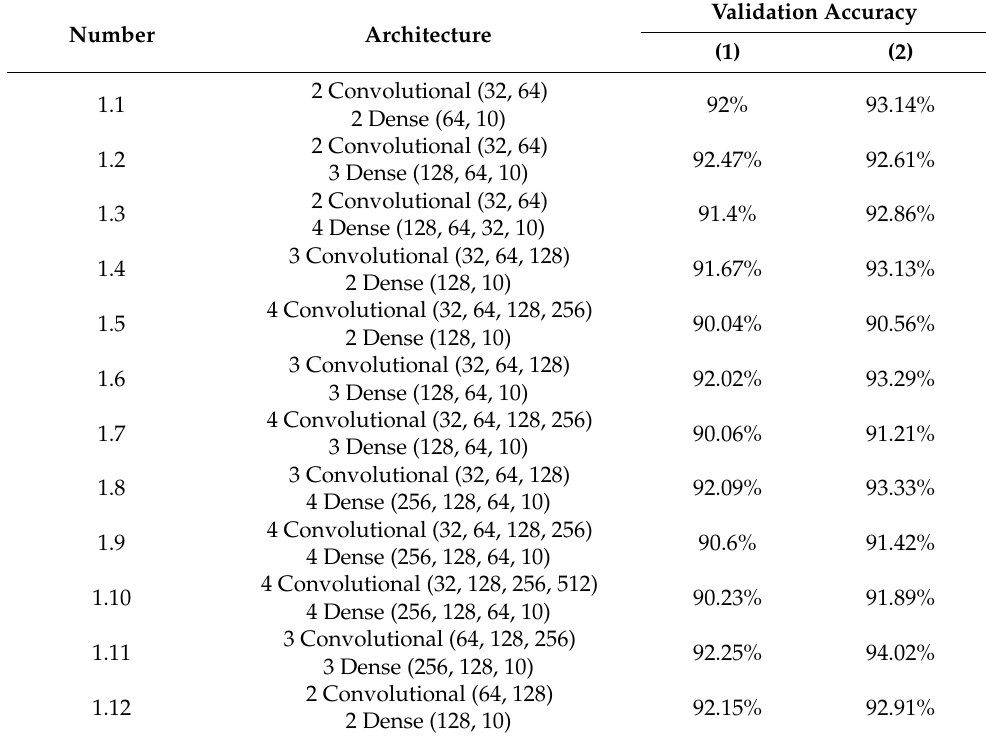
Table 3. One-model approach